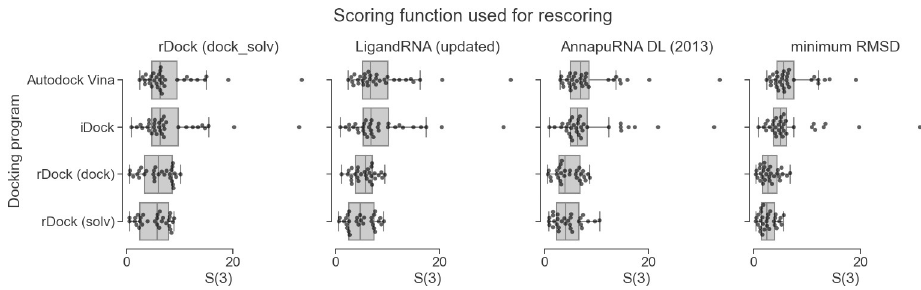
Fig 4. Comparison of the performance of three scoring functions (rDock dock_solv, LigandRNA, and AnnapuRNA) expressed as RMSD to the reference pose of best in top three scored poses ( S (3)), calculated for four docking programs. The fourth column represents the best (lowest) RMSD obtained during docking for each program. Each dot represents one complex from the testing set. Docking was performed with the native conformation of a ligand as an